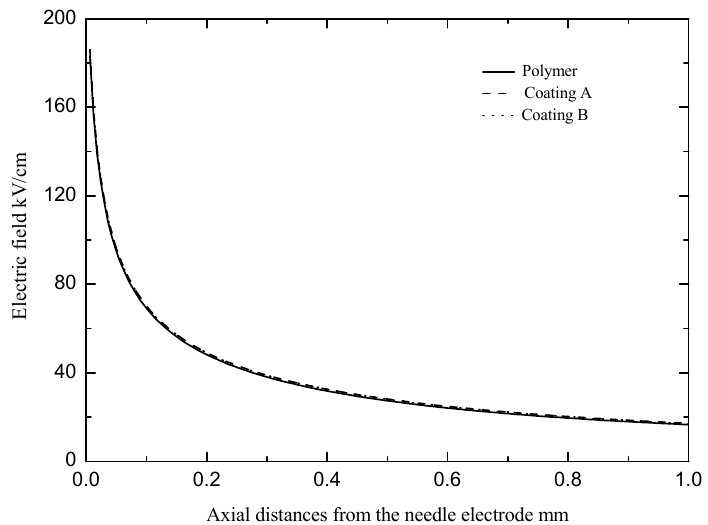
Figure 10. Variation of the electric field from the needle electrode up to 1 mm at axial distances.